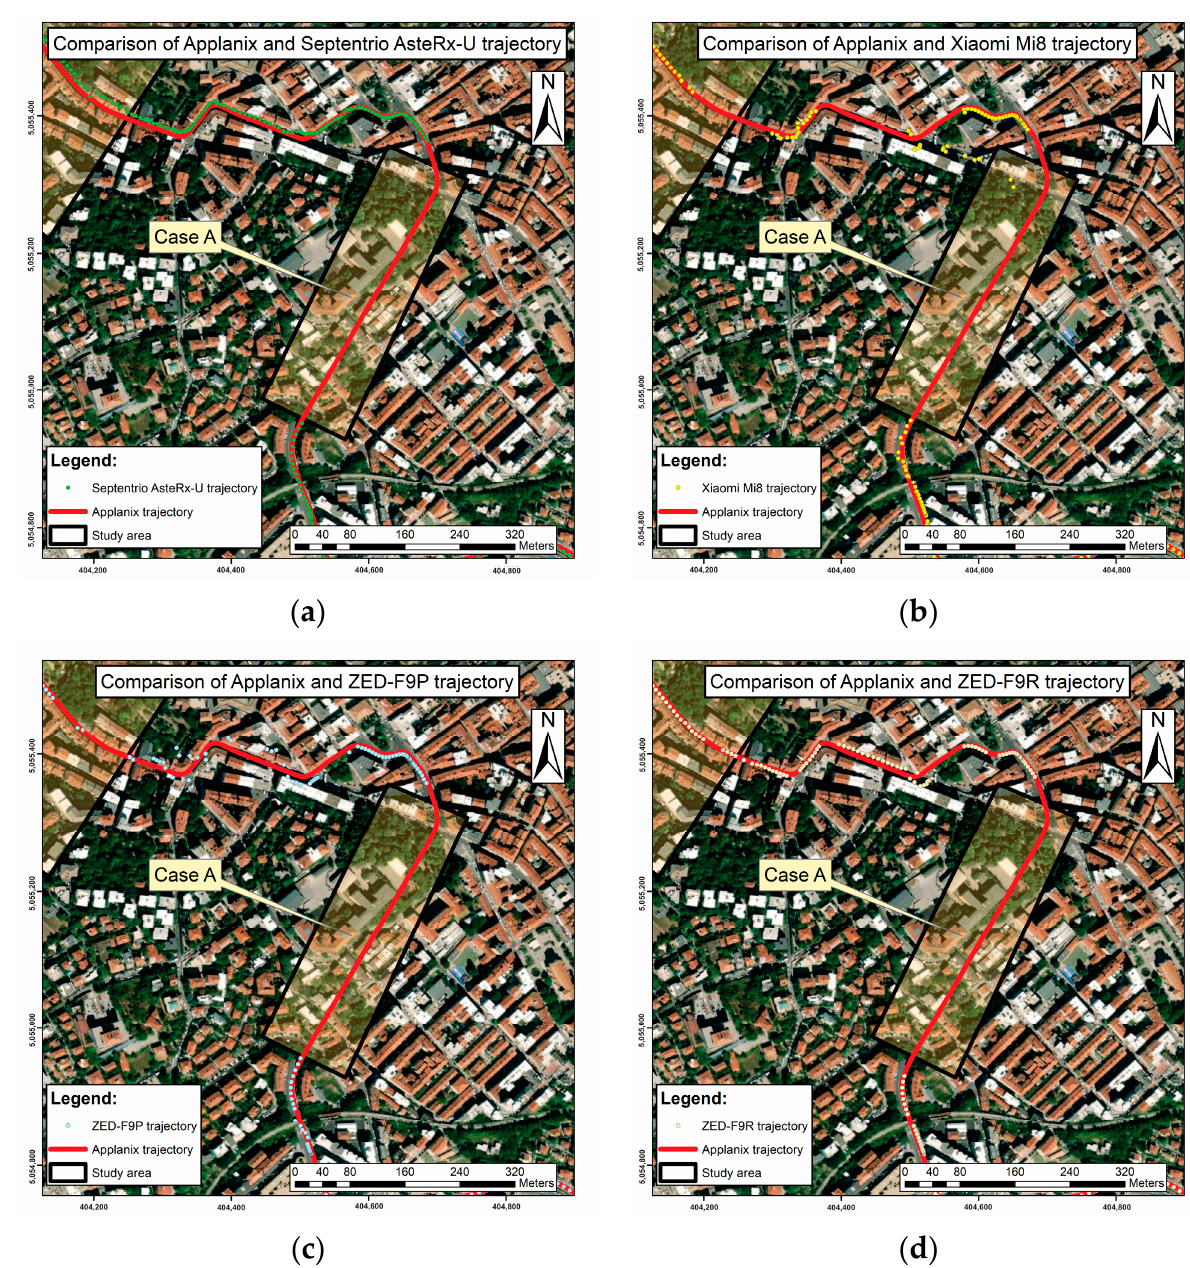
Figure 10. Case A—tunnel: performance of ( a ) Septentrio AsteRx-U, ( b ) Xiaomi Mi8, ( c ) ZED-F9P, and ( d ) ZED-F9R.